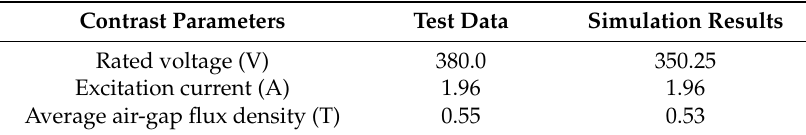
Table 2. Data for no-load characteristic test and simulation